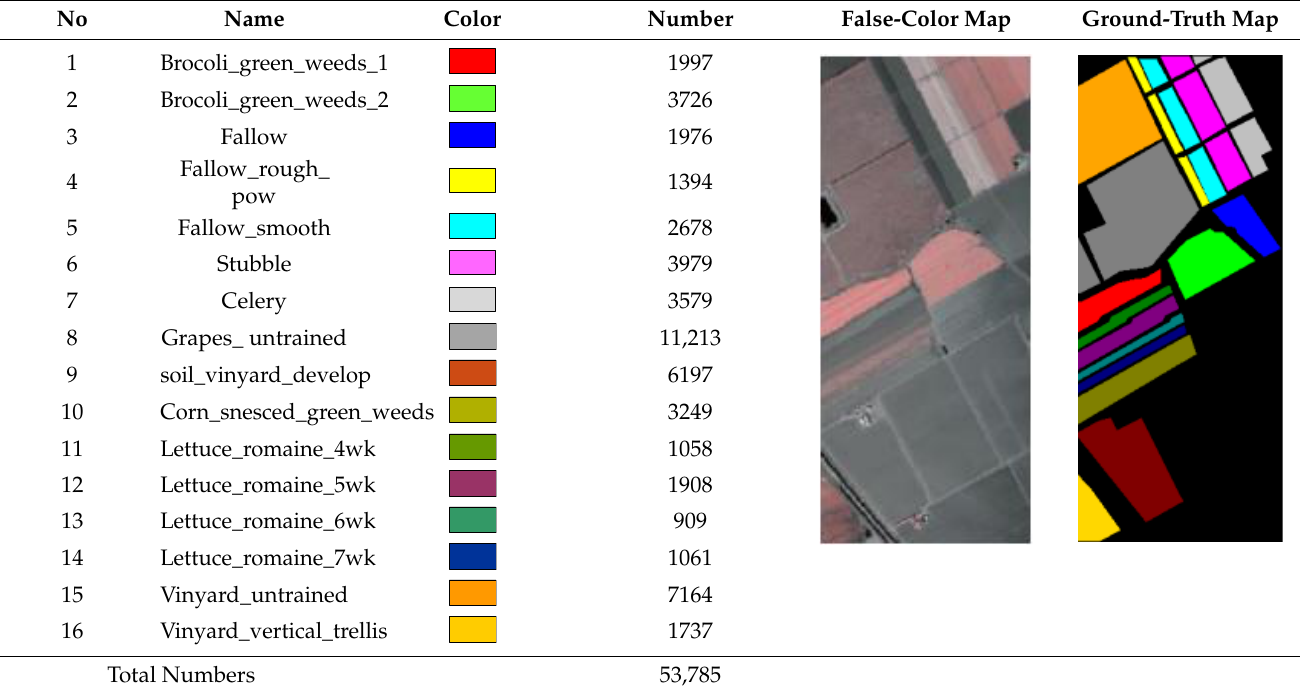
Table 2. KSC Dataset Labeled Sample Table 2. KSC Dataset Labeled Sample Counts. Table 2. KSC Dataset Labeled Sample Counts. Table 2. KSC Dataset Labeled Sample Counts. Table 2. KSC Dataset Labeled Sample Counts. Table 2. KSC Dataset Labeled Sample Counts. Table 2. KSC Dataset Labeled Sample Counts. Table 2. KSC Dataset Labeled Sample Counts. Table 2. KSC Dataset Labeled Sample Counts. Table 2. KSC Dataset Labeled Sample Counts. Table 2. KSC Dataset Labeled Sample Counts. Table 2. KSC Dataset Labeled Sample Counts. Table 2. KSC Dataset Labeled Sample Counts. Table 2. KSC Dataset Labeled Sample Counts. Table 2. KSC Dataset Labeled Sample Counts. Table 2. KSC Dataset Labeled Sample Counts. Table 2. KSC Dataset Labeled Sample Counts. Table 2. KSC Dataset Labeled Sample Counts.